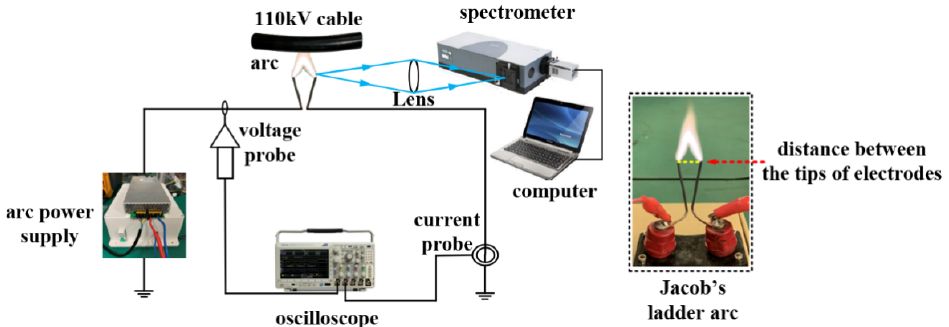
Figure 1. The schematic of the experimental setup.